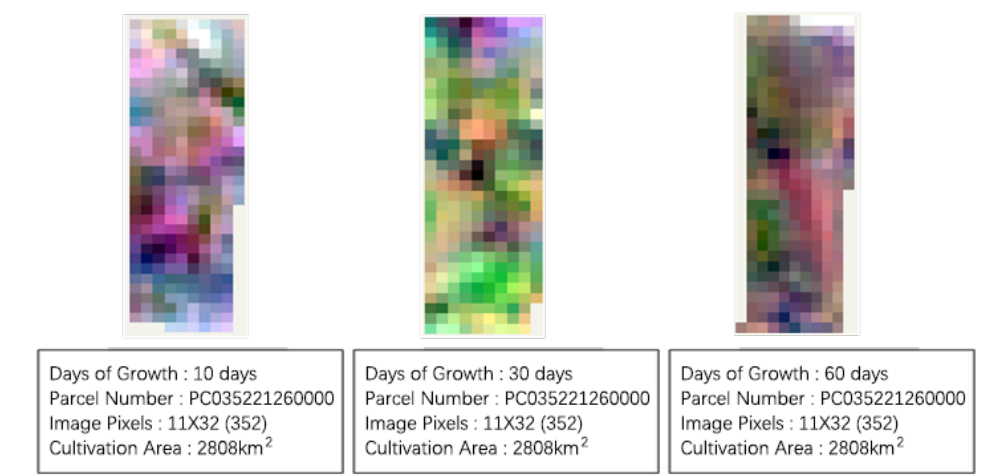
Figure 15. Multitemporal satellite images of cabbages under the same parcel number.